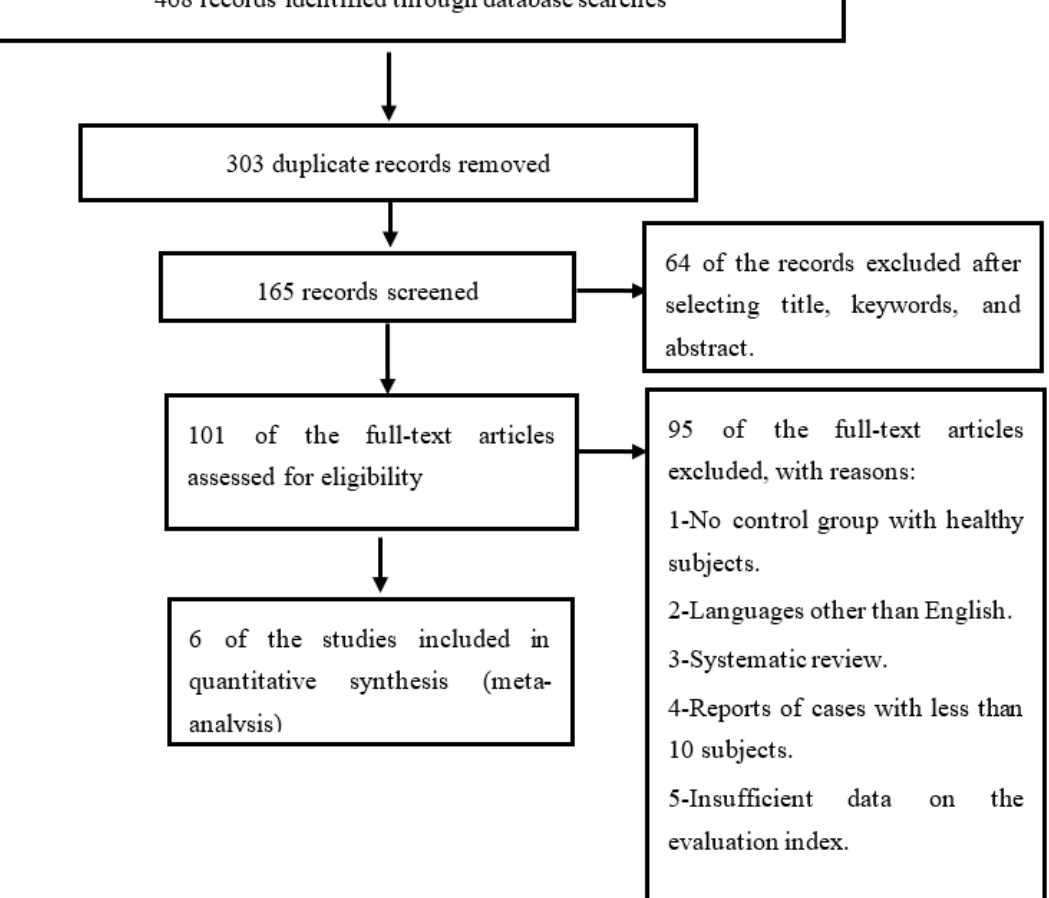
Figure 1. Flowchart of studies included through the systematic review process.